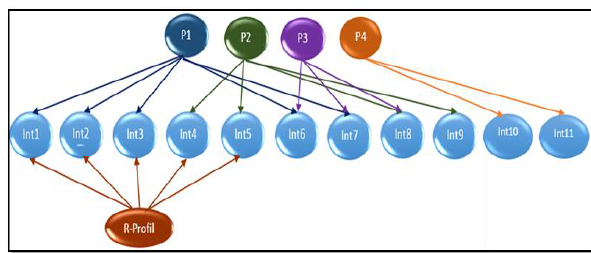
Figure 2. Graph Representing the Profiles P (1, 2, and 3) and the Query R-Profile